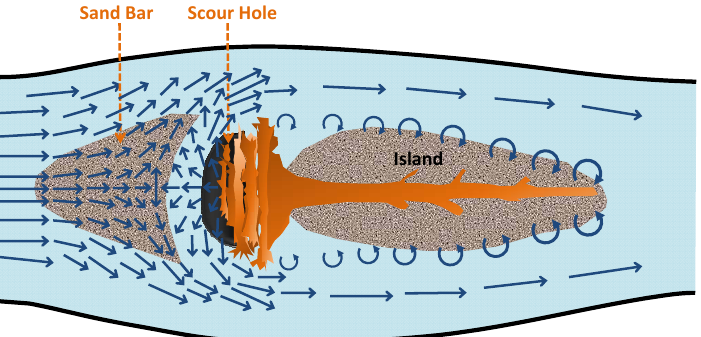
Fig. 6. Bar apex jam: example flow field for an isolated in-channel flow obstruction. (Figure adapted from the work of Abbe and Montgomery, 1996,